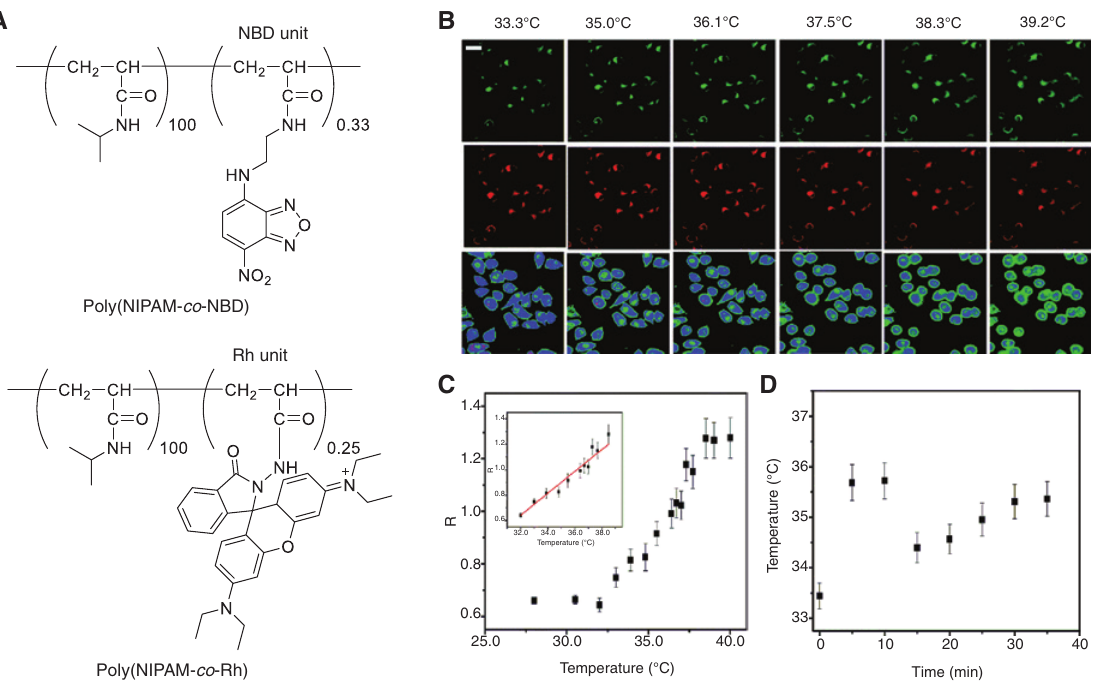
Figure 8: Intracellular thermometry of living HeLa cells with a combination of two poly(NIPAM) copolymers. = 11,062) and poly(NIPAM- co -Rh) ( M = 9896). (B) Fluorescence images of poly(NIPAM- (A) Chemical structures of poly(NIPAM- co -NBD) ( M n n co -NBD) and poly(NIPAM- co -Rh) in living HeLa cells at different temperatures. The images in the first row and the second row were collected in the range of 510–560 nm and 570–670 nm, respectively. The images in the third row were of the ratio of the first and second images. Scar bar = 20 μ m. (C) Temperature-dependent fluorescence intensity ratio (R) obtained from the images shown in panel B. Inset: Calibration line for intracellular thermometry. (D) Change in intracellular temperature of HeLa cells after the chemical stimuli with FCCP. Reproduced with permission from Qiao et al. (2014). Copyright 2014 Royal Society of Chemistry.